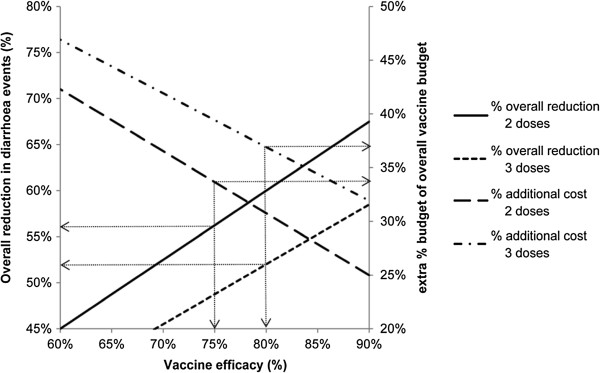
Effect of vaccine efficacy on total cost and effect. Total cost (right Y-axis) and effect (reduction in diarrhoea events, left Y-axis) as a function of vaccine efficacy. Assumptions: vaccine budget, $195,000; 2-dose vaccine efficacy (strategy A), 75%; 3-dose vaccine efficacy (strategy B), allowed to vary; target vaccine coverage, 75%; 2-dose vaccine cost per dose (strategy A), $13.00; 3-dose vaccine cost per dose (strategy B), $10.00.